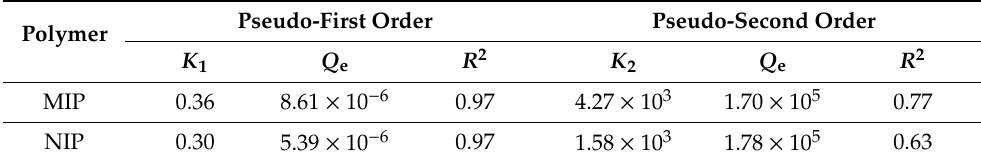
Table 5. Kinetic fitting data for MIP and